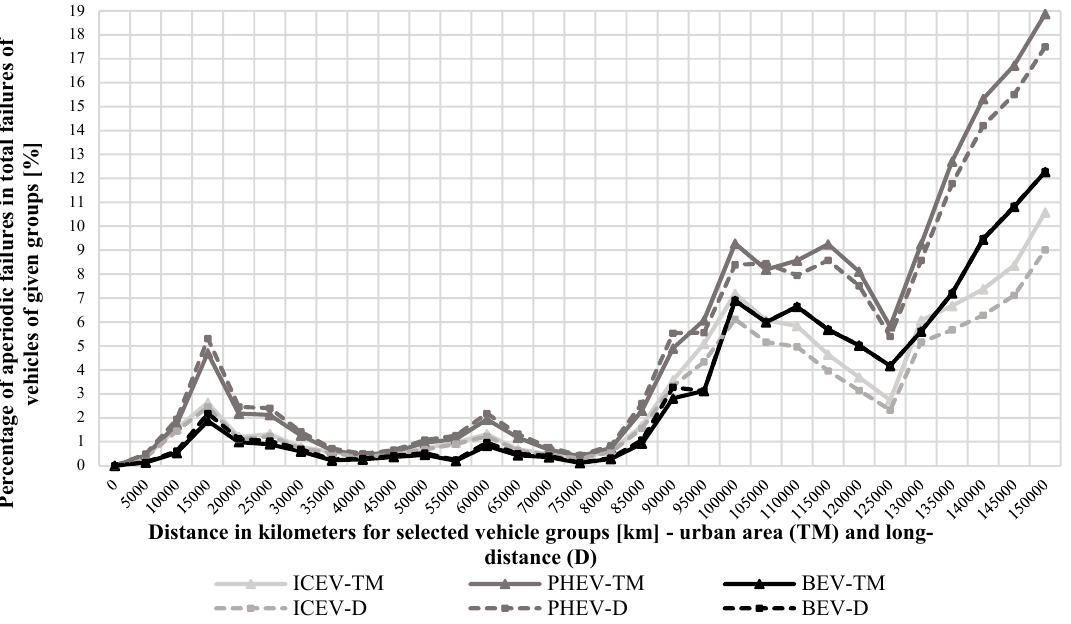
Figure 8. Distribution of aperiodic failures for a medium limousine with ICEV, PHEV, and BEV propulsion for urban and long-distance speed profiles over a distance of 150,000 km.